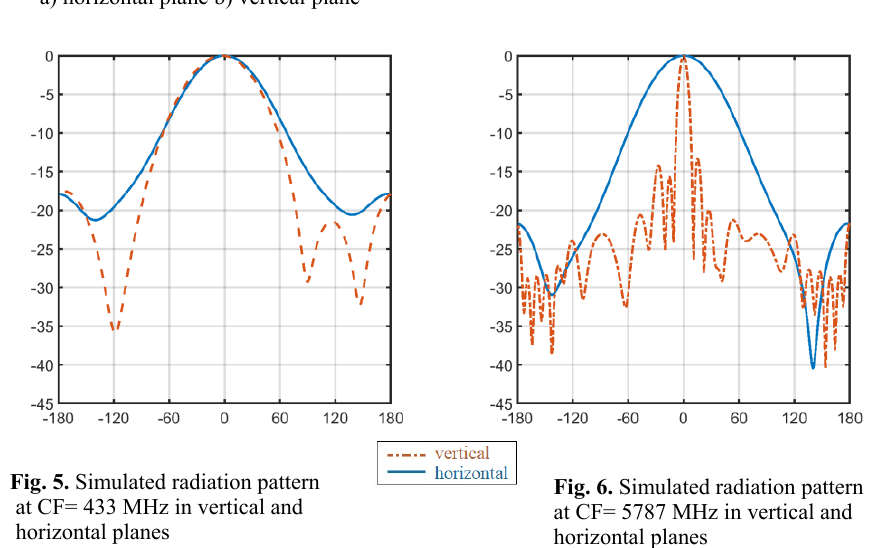
Fig. 5. Simulated radiation pattern at CF= 433 MHz in vertical and horizontal planes